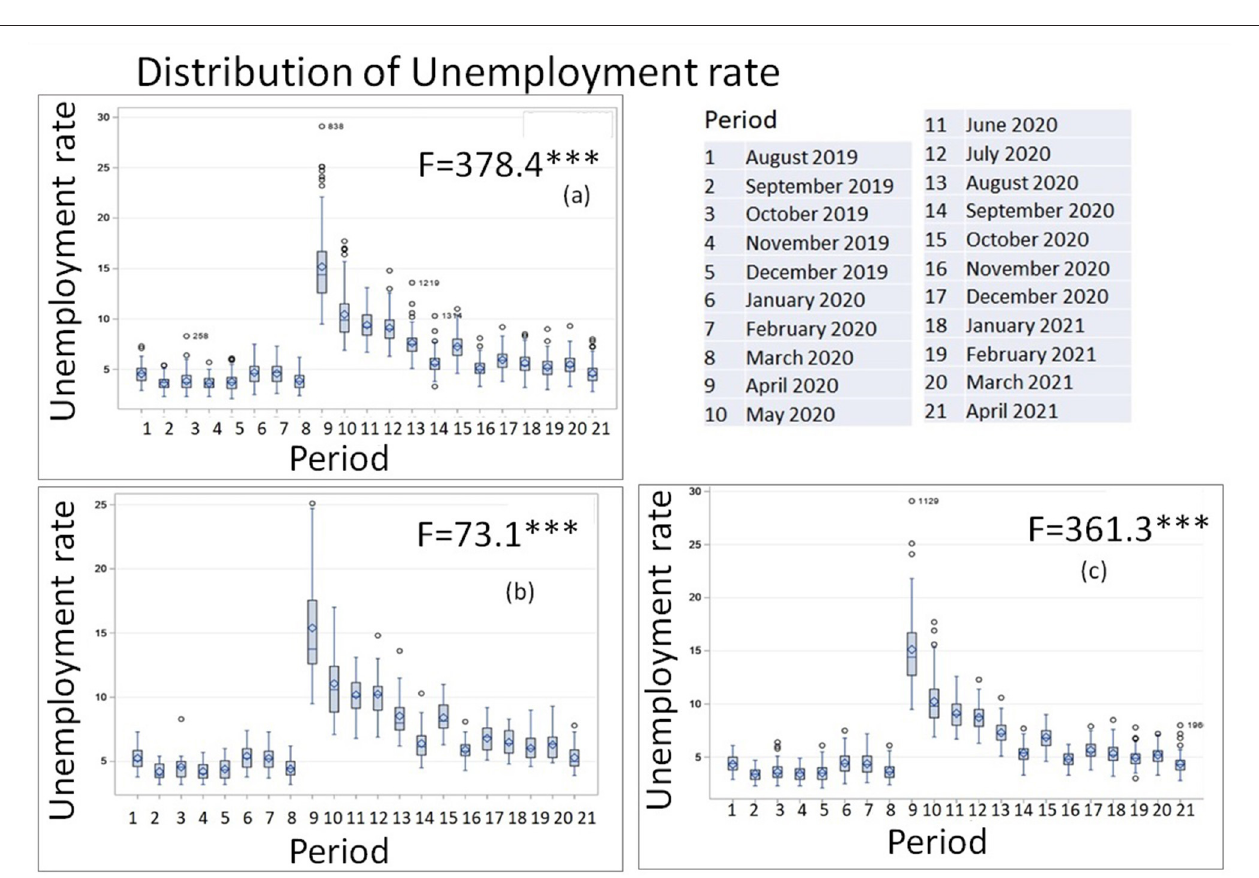
FIGURE 4 | One-Way ANOVA of unemployed rate for: (A) all counties combined for 15 months (August 2019–April 2021), regardless of social disadvantage status; and by social disadvantage status, (B) for counties with high social disadvantage; (C) for counties with low social disadvantage.